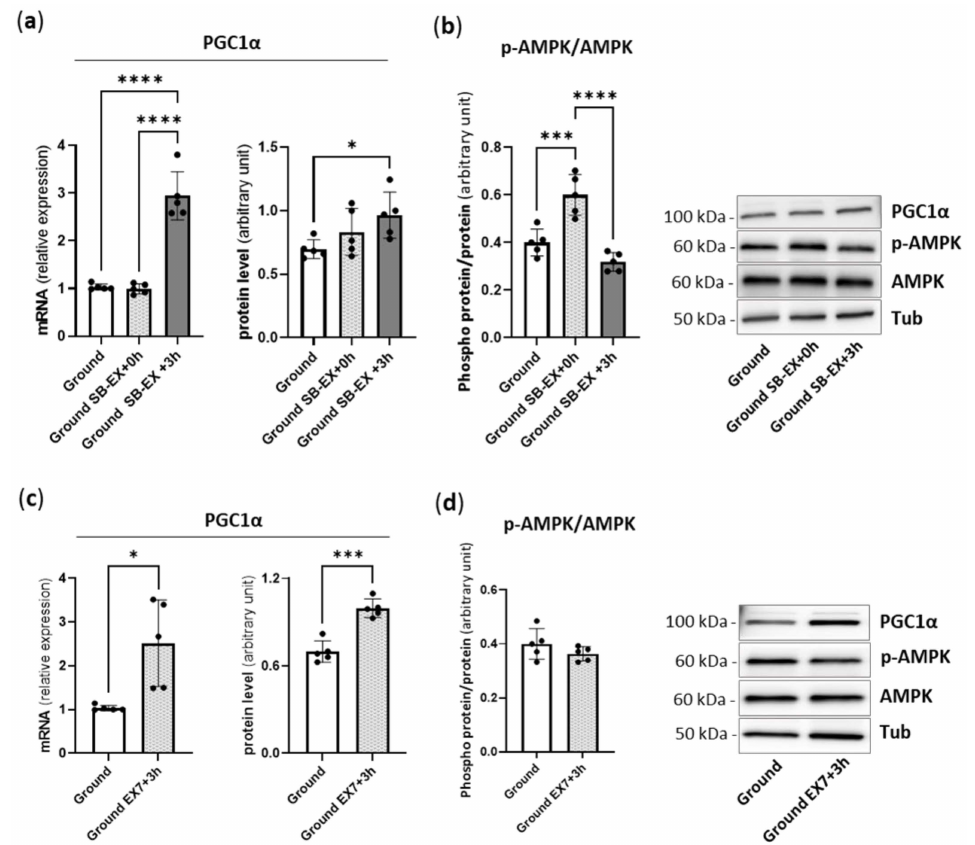
Figure 1. A single exercise bout and 7-day endurance training increase mRNA and protein expression of PGC 1 α in ground mice . Gene expression and protein content analysis of PGC 1 α ( a ) and activation level of AMP-kinase ( b ) in gastrocnemius of mice subjected to a single bout of treadmill exercise and relative representative Western blot; protein levels were normalized for tubulin expression. Ground: Control mice ; Ground SB-EX + 0 h: Mice subjected to a single bout of exercise sacrificed immediately or 3 h after exercise (Ground SB-EX + 3 h). Gene expression and protein content analysis of PGC 1 α ( c ) and activation level of AMP-kinase ( d ) in gastrocnemius of trained mice and relative representative Western blot; protein levels were normalized for tubulin expression. Ground: Control mice ; Ground EX7 + 3 h: Mice subjected to 7 days of endurance exercise sacrificed 3 h after the last section of exercise. The activation level of AMP-kinase was determined through the ratio between the content of the phosphorylated ( p ) and total form. Data are presented as means ± SD * p < 0.05 *** p < 0.0005 **** p <